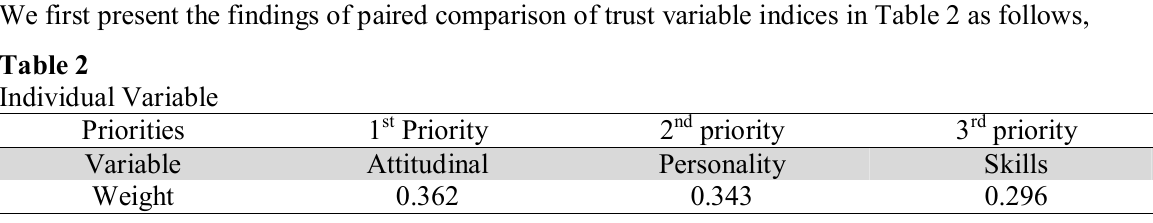
The results of consistency ratios Matrices